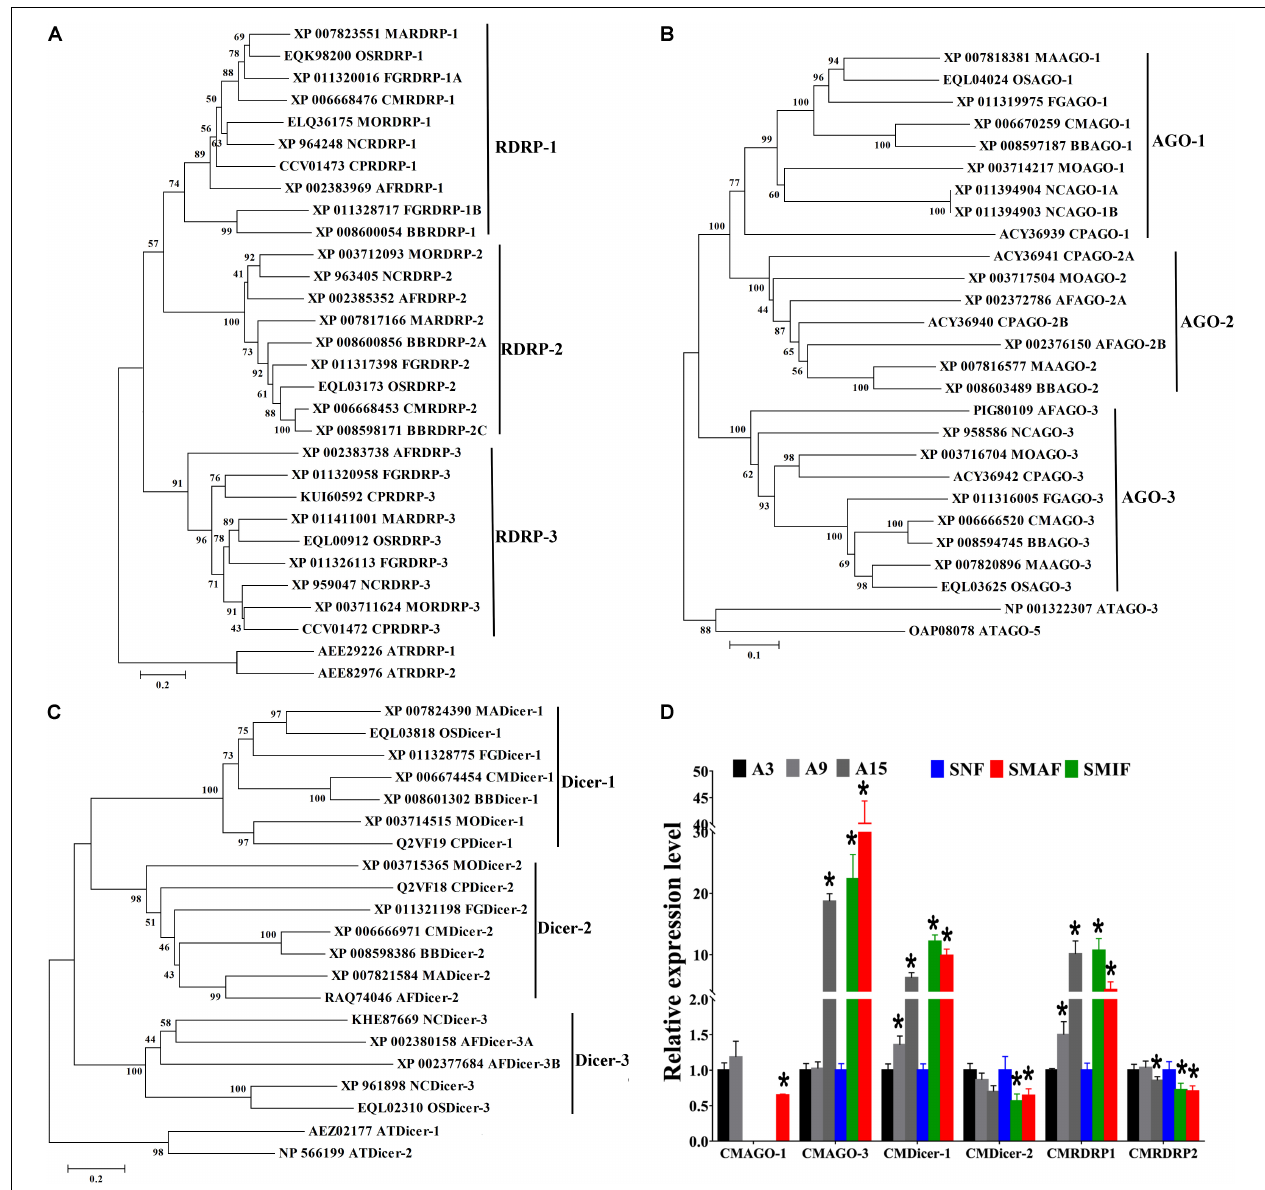
FIGURE 1 | Phylogenetic analysis and expression profiles of Dicers, RDRPs, and AGOs in C. militaris and other fungi. Phylogenetic trees constructed with fungal Dicer (A) , RDRP (B) , and AGO (C) proteins. CM, Cordyceps militaris ; BB, Beauveria bassiana ; MA, Metarhizium robertsii ; OS, Ophiocordyceps sinensis ; MO, Magnaporthe oryzae ; FG, Fusarium graminearum ; CP, Cryphonectria parasitica ; NC, Neurospora crassa ; AF, Aspergillus flavus ; AT, Arabidopsis thaliana . Expression profiles of Dicers, RDRPs, and AGOs at different developmental stages of C. militaris (D) . Total RNAs were extracted at different asexual developmental stages of C. militaris , i.e., 3-day-old (A3), 9-day-old (A9), and 15-day-old (A15), and from different sexual developmental stages, i.e., nascent (SNF), stalk formation (SMIF), and mature fruiting bodies (SMAF). Data are expressed as means ± SE of the values from six independent experiments. Student’s t -test was used to determine